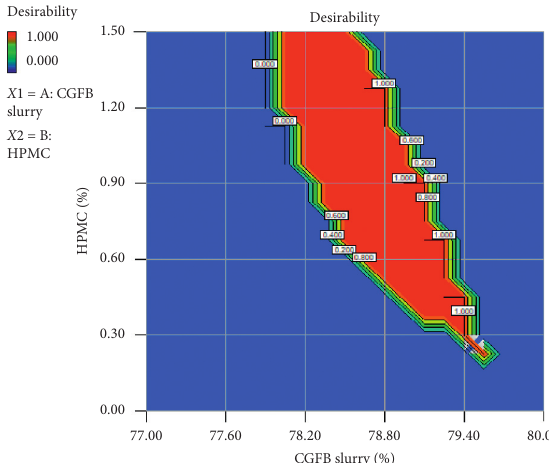
Figure 9: Multiobjective optimization results. Table 7: Material proportioning scheme of the three samples.